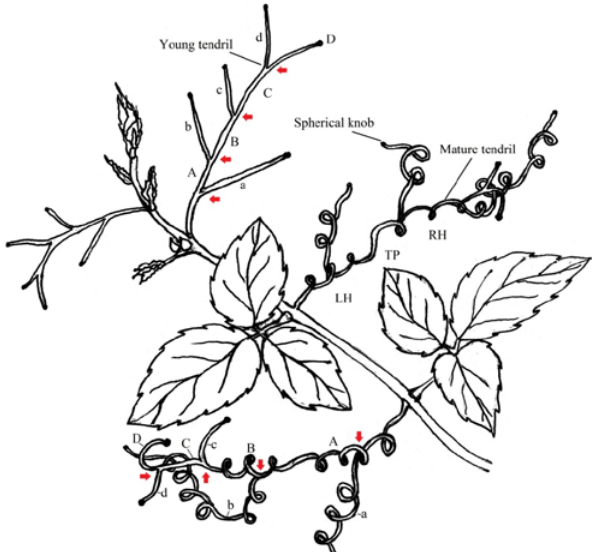
Fig. 3. The branched tendrils of Cayratia trifolia The mature tendrils show both left- handed (LH) and right-handed (RH) coiling with point of tendril perversion (TP). The arrow indicates branching node. At each branching point, the two branches are labeled as A-a, B-b, C-c and D-d, respectively. Tendril branch ‘A’ bipartite to B-b branch, branch ‘B’ to C-c branch and eventually branch ‘C’ to D-d branch. The branches ‘a’, ‘b’, ‘c’ and ‘d’ remains un-branched. All branches show spherical knob like structure. The knob indicates termination of the